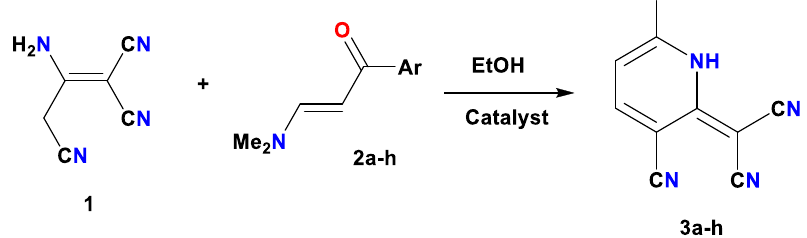
6 of 11 Figure 6. Optimization of the chitosan graft copolymer as basic catalyst. Table 1. Recyclability of the chitosan graft copolymer as basic catalyst. State of Catalyst